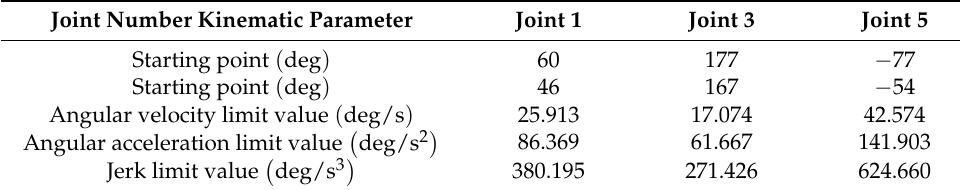
Table 3. Results of kinematic parameter planning for each